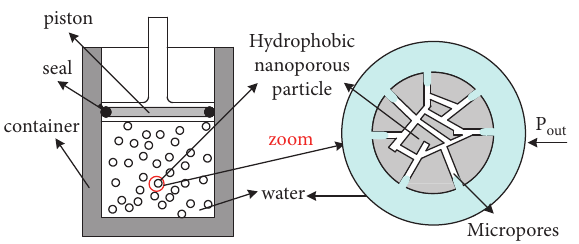
Figure 1: Intrusion of water into hydrophobic